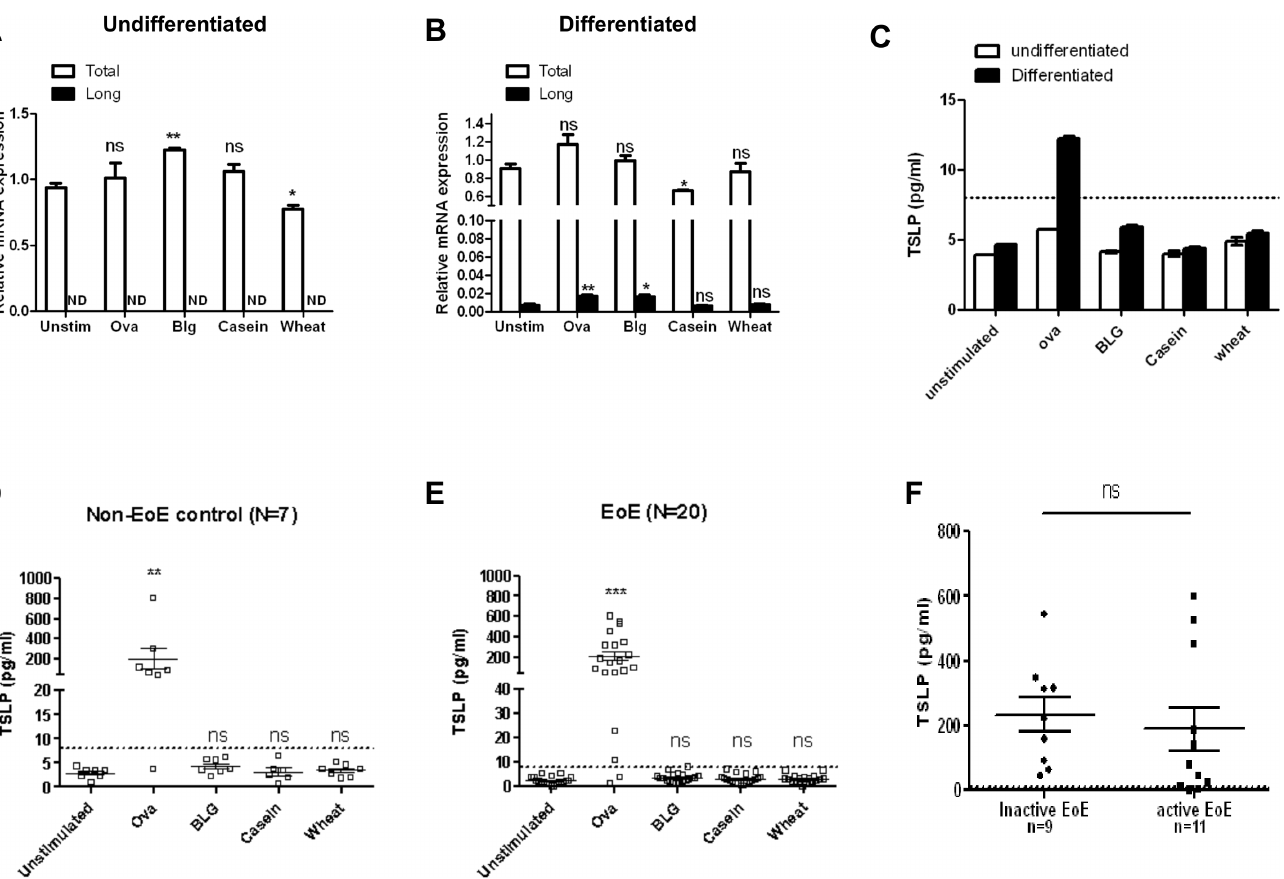
Fig 4. Food antigens induce esophageal epithelial TSLP expression. Quantification of TSLP mRNA expression following food antigen stimulation in undifferentiated (A) and differentiated (B) EPC2-hTERT cells. C ) TSLP secretion (pg/mL) was quantified in undifferentiated and differentiated EPC2-hTERT cells. TSLP secretion in differentiated primary esophageal epithelial cells from non-EoE control subjects (N = 7) (D) and EoE subjects (N = 20) (E) following stimulation with food antigens. All cell lines were stimulated for 24 hours. ( F ) comparison of ova mediated TSLP expression in differentiated inactive and active EoE cells. The dashed lines represent the lower limit of sensitivity of the ELISA kit (8pg/mL). Bars represent the mean of each data set. * p < 0.05, ** p < 0.01, *** p < 0.001 as compared to unstimulated controls.